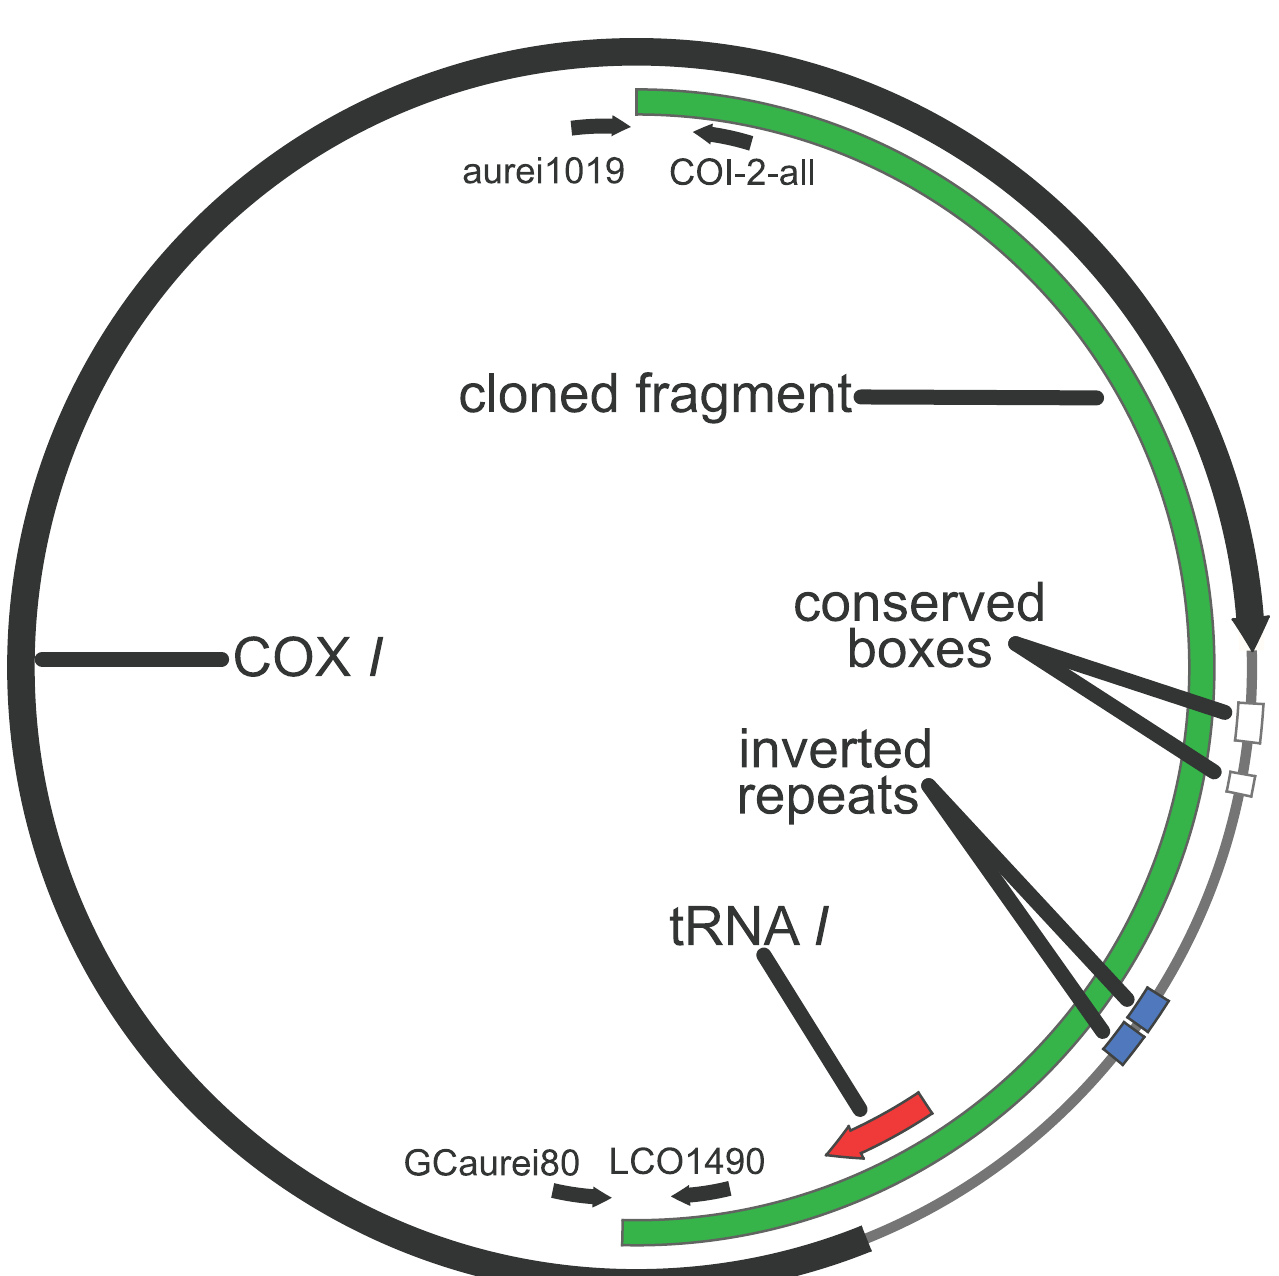
Fig 4. Thomomydoecus minor cox1 Minichromosome. Fully constructed minichromosome showing the relative positions of cox1 , trn I , inverted repeat regions, PCR primers (shown as small black arrows), and the cloned region of the chromosome (Clone 1).